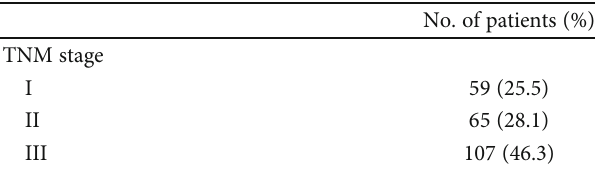
Table 1: Clinical and laboratory characteristics of 231 GC